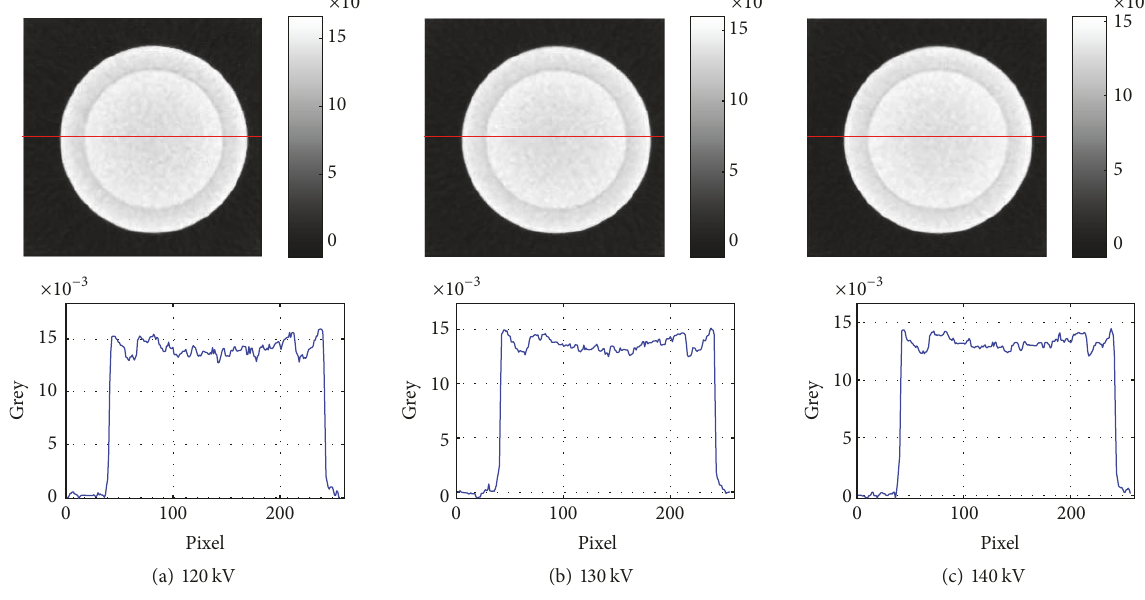
Figure 2: Direct reconstructed images.